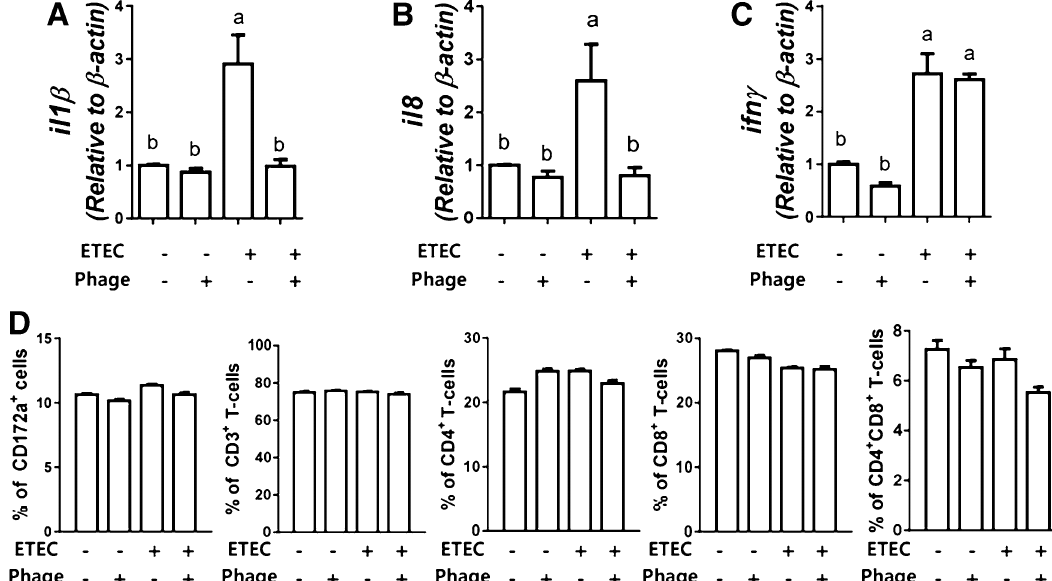
Figure 5. Phage EK99P-1 alleviated the inflammatory response of immune cells under IPEC-J2 infection with ETEC K99. Differentiated IPEC-J2 and pPBMCs were co-cultured using transwell plates. IPEC-J2 were treated with ETEC K99 (1 × 10 7 cfu/mL) and phage EK99P-1 (1 × 10 6 pfu/mL) on the apical side for 24 h. ( A–C ) Expression of cytokine mRNA in pPBMC was measured by real-time quantitative RT-PCR (qRT-PCR; n = 3). ( D ) pPBMCs were stained with anti-CD172a, -CD3e, -CD4, or -CD8a antibodies to analyze the population of immune cells using flow cytometry. Data are mean percentages of each cell population relative to the total cells ± SD (n = 3). Means were compared using one-way ANOVA, followed by a Friedman test corrected by Tukey’s multiple comparison test. Different letters in each group indicate significant differences at P <